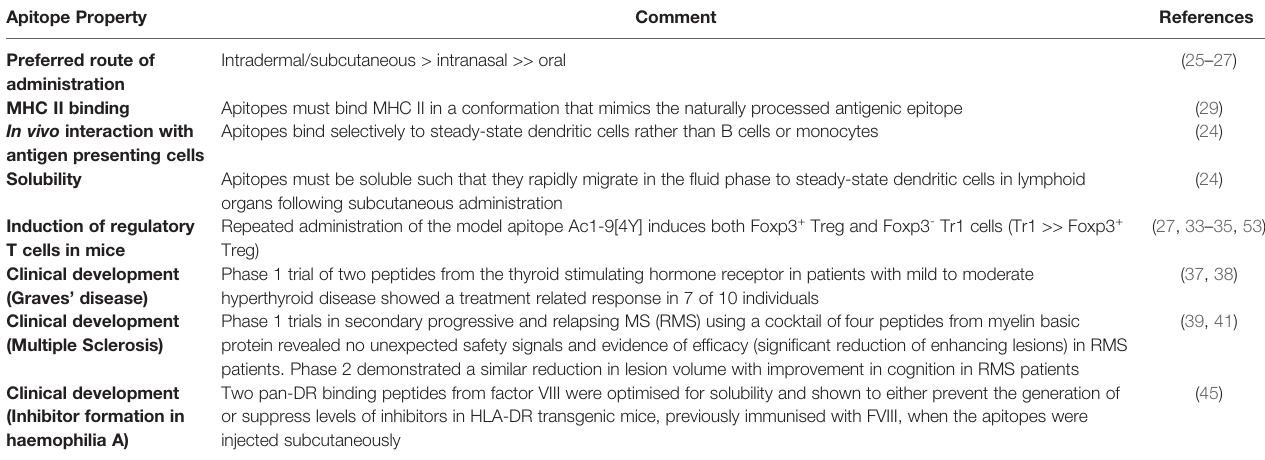
TABLE 1 | Properties of antigen processing independent T cell epitopes (apitopes) designed for antigen-speci fi c immunotherapy. Apitope